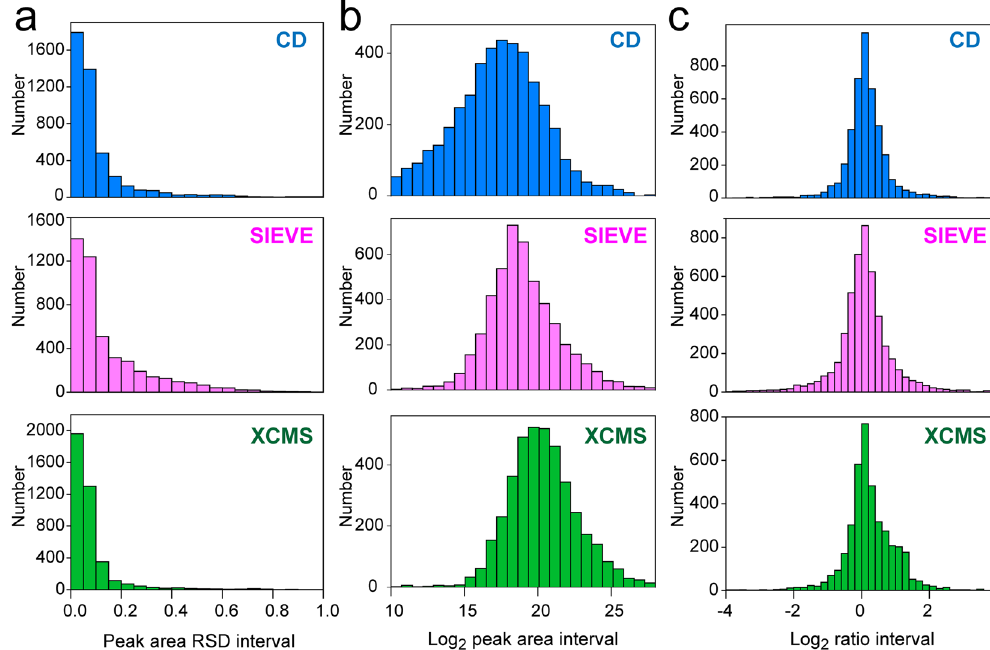
Figure 1. Data processing evaluation of three software packages, Compound Discoverer, SIEVE, and XCMS Online. ( a ) Histograms of peak area relative standard deviations (RSD) of all detected features in QC data set. ( b ) Histograms of log 2 -transformed peak areas of all detected features in QC data set. ( c ) Histograms of log 2 - transformed ratios of all detected features in preclinical AD vs. control data